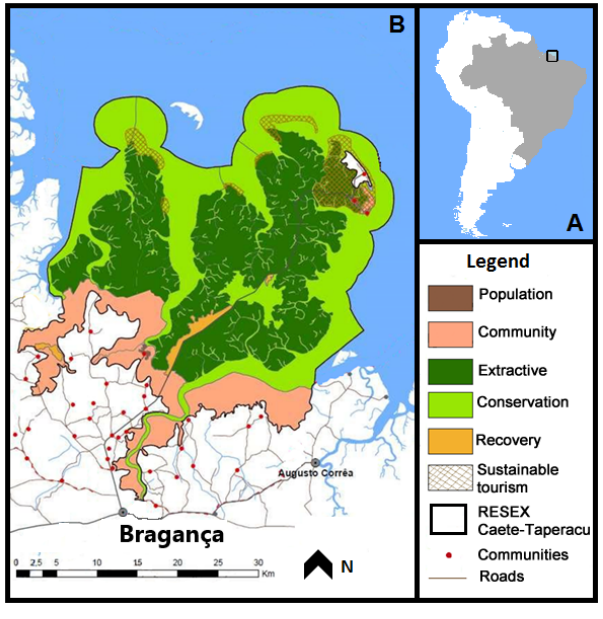
Fig. 1 . (A) Location of the Caeté-Taperaçú RESEX in Brazil. (B) Bragança area and the RESEX boundaries and